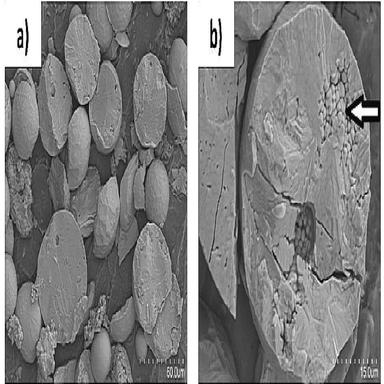
Micrographs showing a) the interior structures of individual particles and b) particles seen to be formed by the combination of many initially smaller particles.